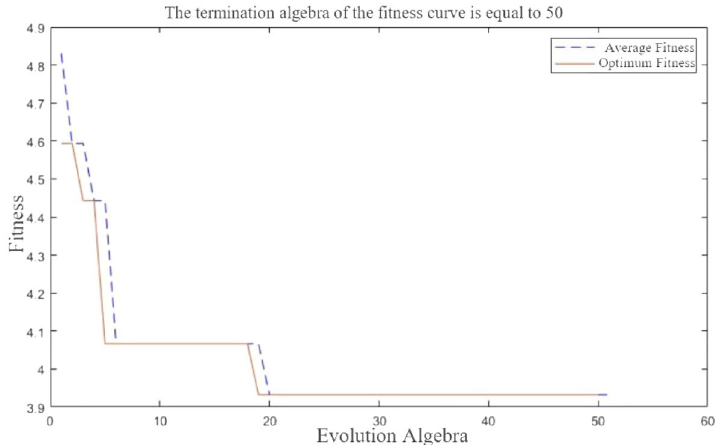
Figure 20. Convergence graph of training iterations.